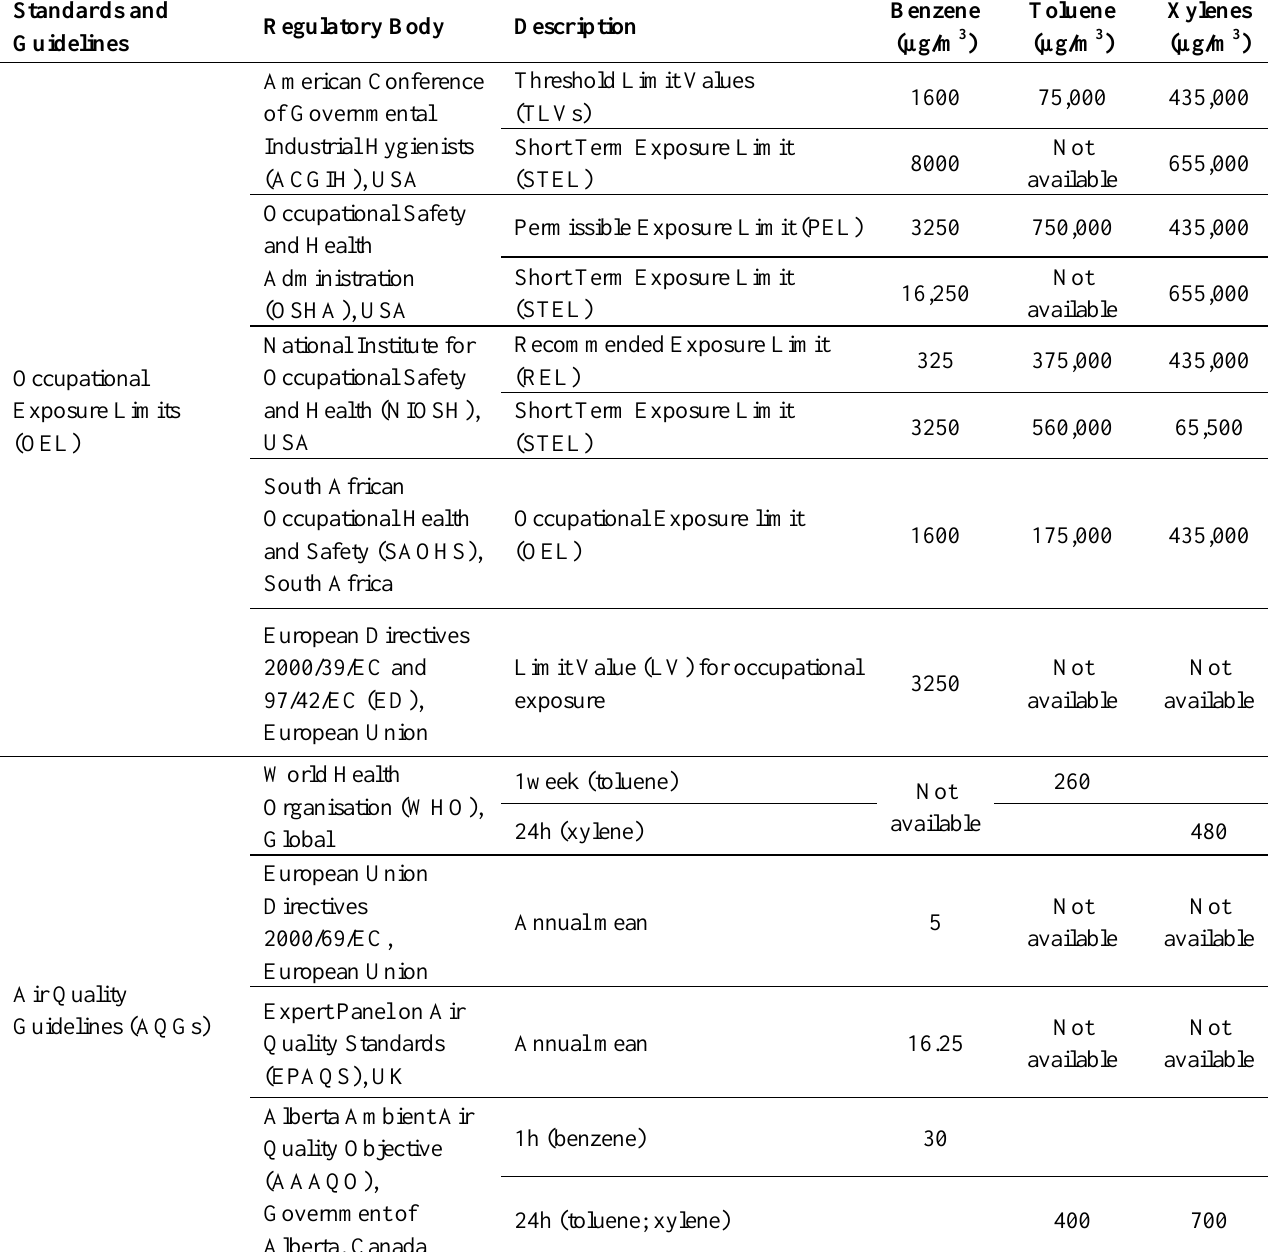
Table 2. Occupational exposure limits and air quality guideline values for exposure to benzene, toluene and